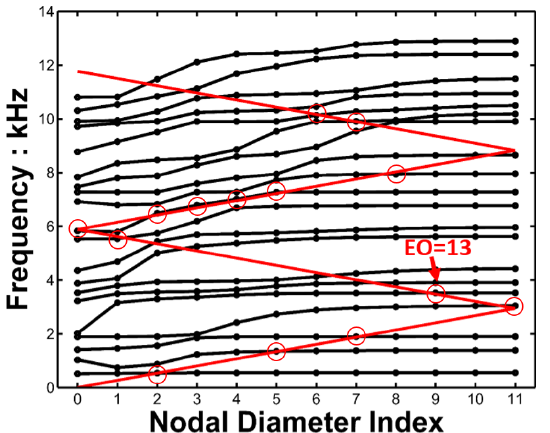
Figure 2. ZZENF diagram of the Rotor67 bladed disk system. Zig-zag-shaped excitation line (red) in the nodal diameters versus frequency diagram (black spot). Possible resonances are marked with red circles.